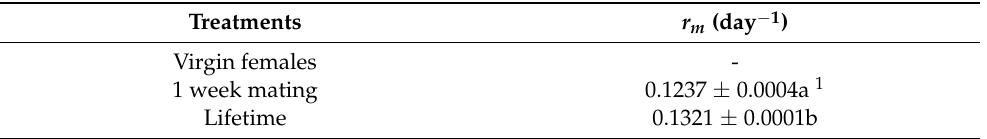
Table 1. Intrinsic rates of population increase ( r m ) of Chrysoperla agilis depending on the duration of male availability to females for